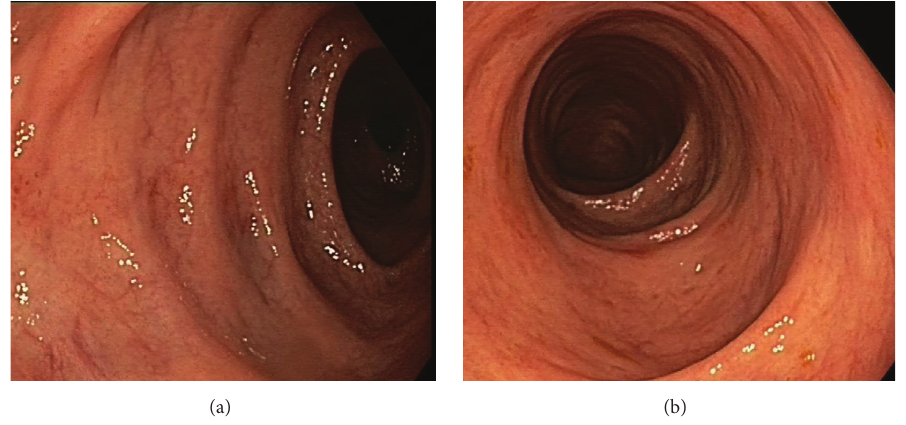
Figure 1: Macroscopic findings at colonoscopy. Ascending colon (a) and descending colon (b) are shown.